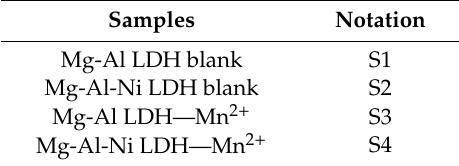
Table 1. Notation of samples (before and after adsorption of Mn 2+ ).